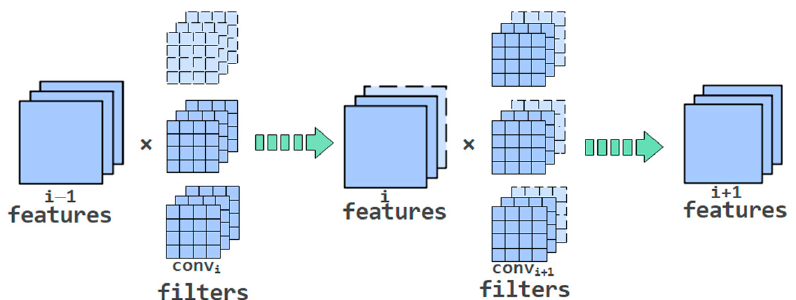
Figure 2. The workflow of L1-norm-based model pruning, in which the light-colored structure should be pruned. If one filter in conv i is pruned, its corresponding feature map in layer i will be removed. Then, the filters in conv i + 1 will be adjusted to fit structural changes.